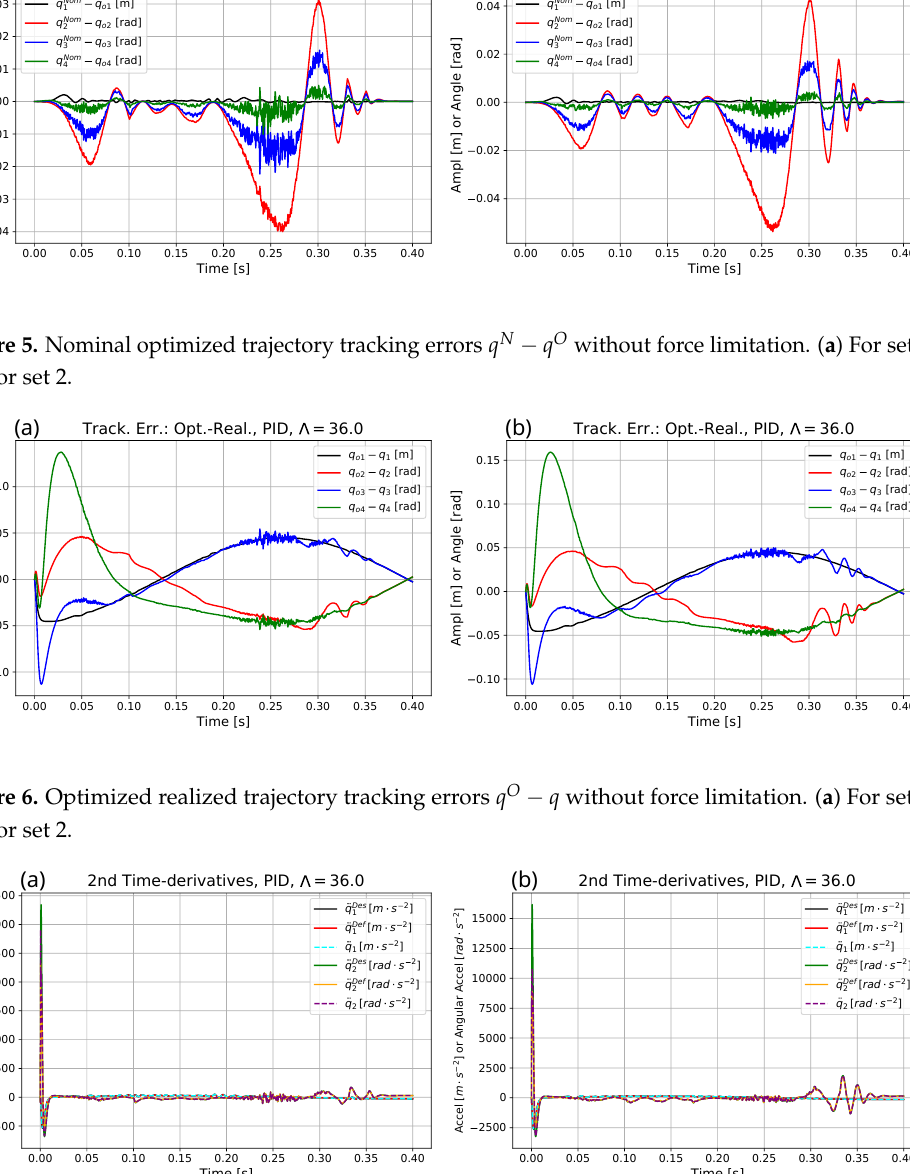
Figure 7. Second time derivatives without force limitation for the joint coordinates q 1 ( t ) and q 2 ( t ) in full scale. ( a ) For set 1. ( b ) For set